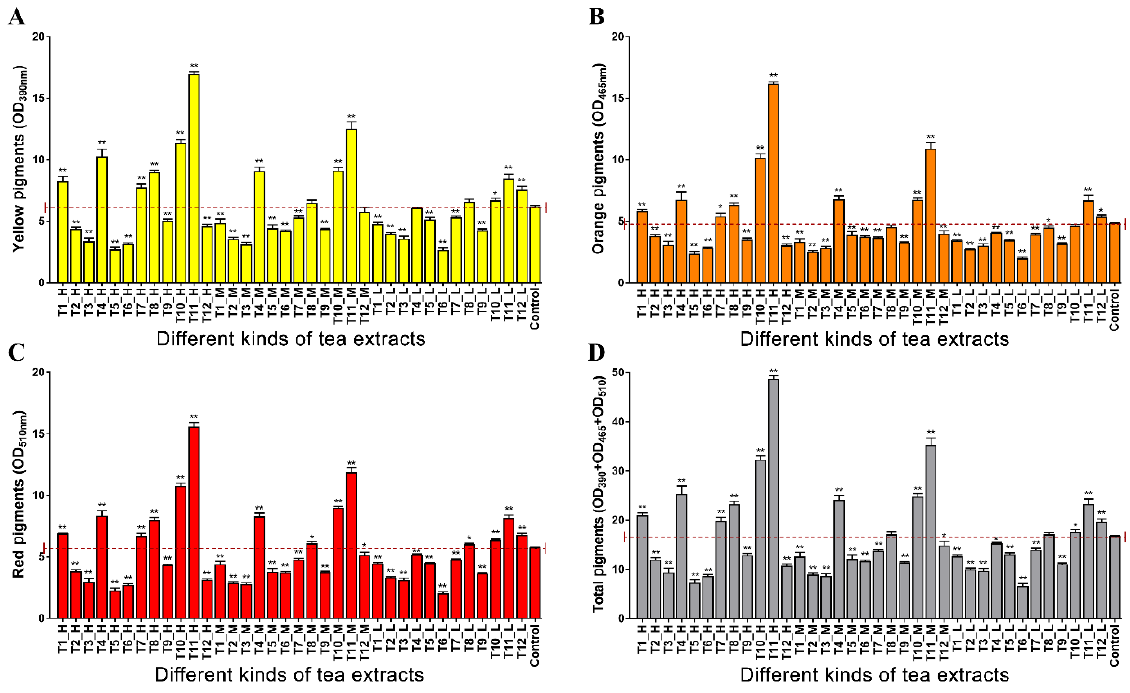
Figure 1. Effect of tea extracts on MPs production of M. purpureus M3. Figures ( A – D ) represent the color values of yellow pigments, orange pigments, red pigments and total pigments, respectively. Color values were used to measure the production of pigments among different groups. T1–T3, T4–T6, T7–T9 and T10–T12 are extracts of green tea, black tea, white tea and pu-erh tea in water, 15% ethanol and 75% ethanol, respectively. H, M and L represent the total polyphenol concentrations of 250 μ g/mL, 125 μ g/mL and 62.5 μ g/mL in tea extracts, respectively. The red dashed line represents the average color value of the control group. Note: * p < 0.05 and ** p < 0.01 versus the Con group.